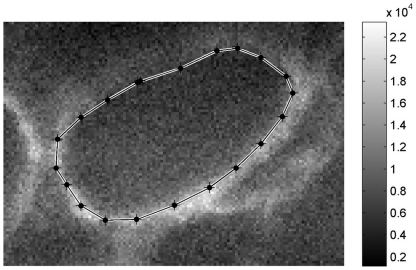
Fluorescence inside and next to an ofloxacin-treated bacterial
mass.The position of the bacterial mass border was superimposed on the
fluorescence map of the 510–560 nm range. For transmission image,
see figure 5B.